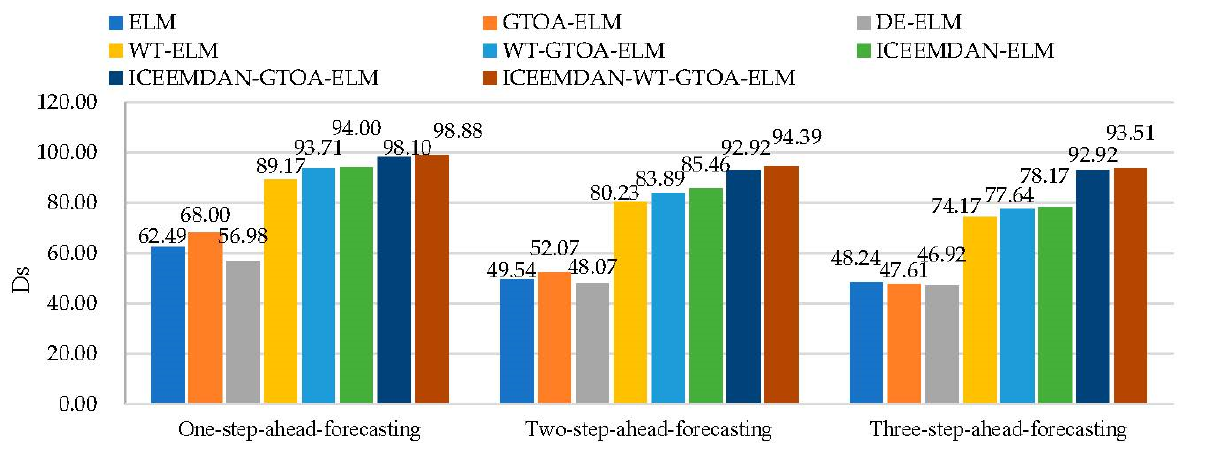
Figure 13. Ds of PM2.5 forecasting. Table 5. DM test results of one-step ahead forecasting of PM2.5.